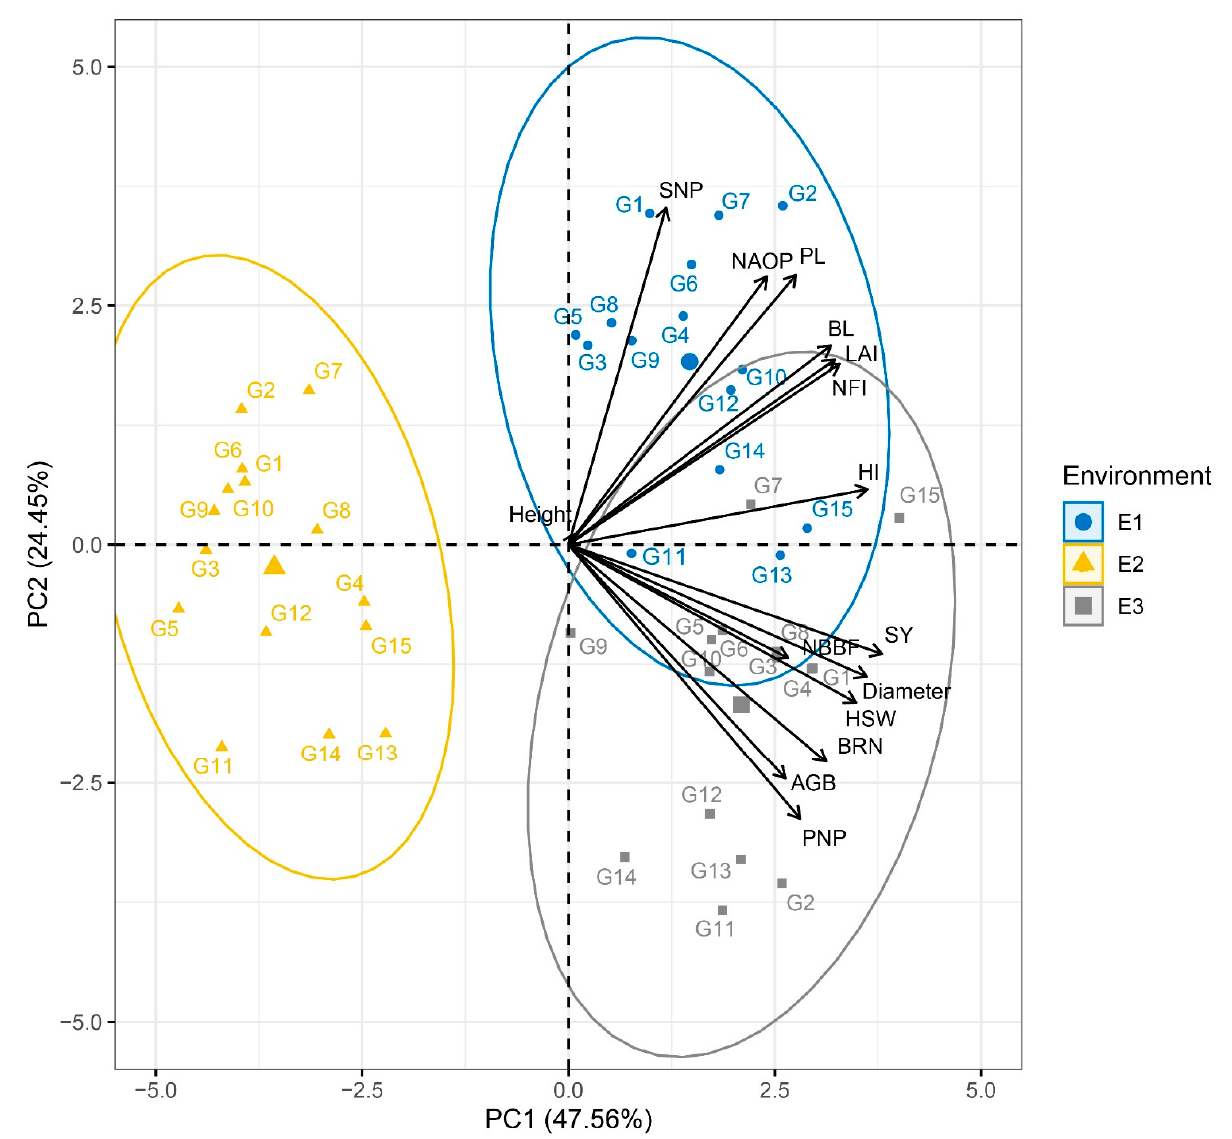
Figure 4. Principal component analysis (PCA) biplot of faba bean yield and morphologic parameters as a function of environment and landraces. The principal variables are denoted by black arrows. Each ellipse represents a 95% confidence interval around each group. See Figure 3 for the complete trait description.